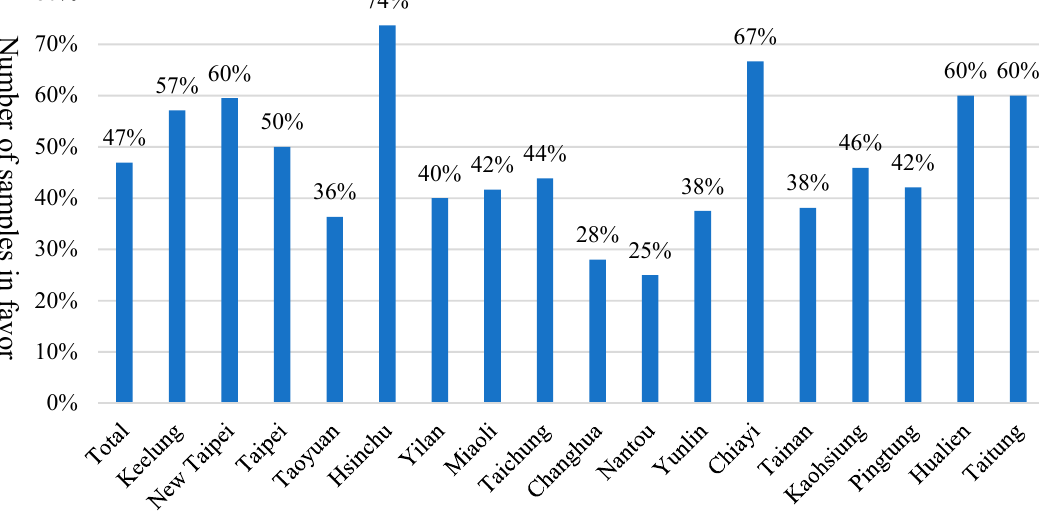
Figure 3. Supporting ratio of adaptation policies in response to climate change when the respondents imagined that they were forest owners (question 9).